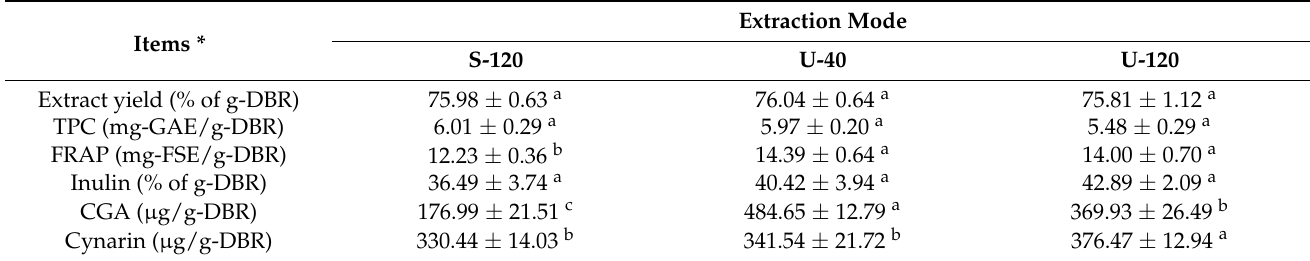
Table 1. Comparison of total phenolic content (TPC), ferric-reducing antioxidant power (FRAP), inulin, chlorogenic acid (CGA), and cynarin in the dried burdock root powder (DBR) between using ultrasound at 40 kHz/300 W (U-40), ultrasound at 120 kHz/300 W (U-120), and shaking at 120 rpm